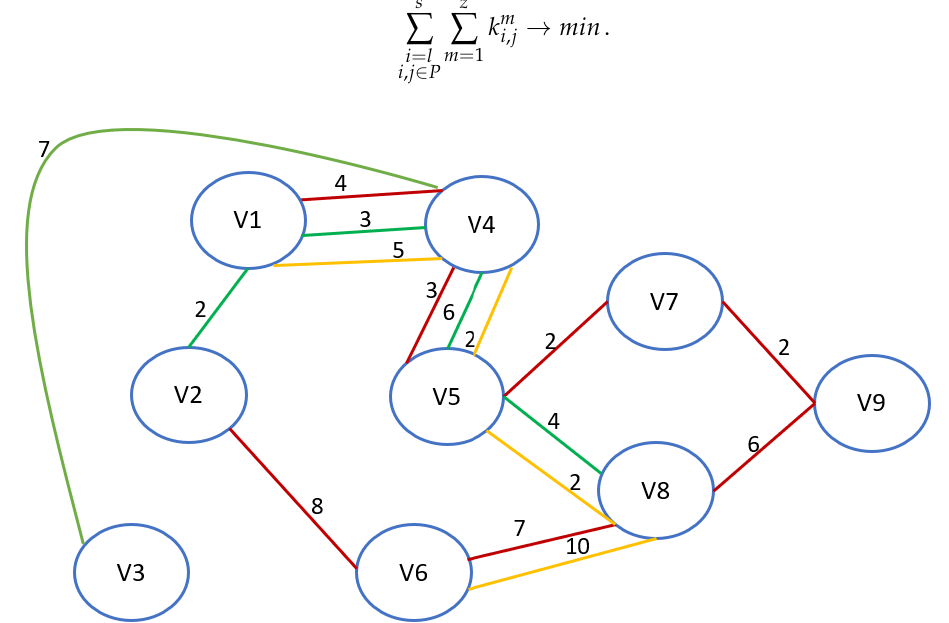
Figure 2. Merged multilayer data transmission network .